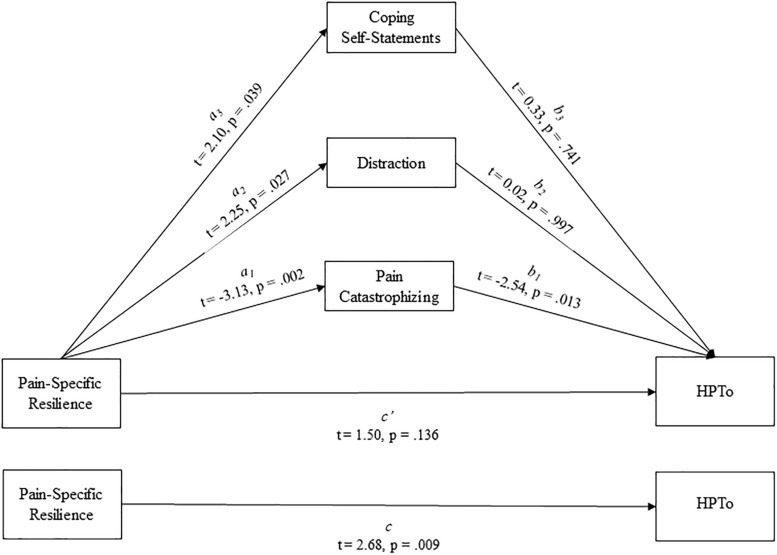
Parallel mediation model depicting the indirect effects of pain-specific resilience on heat pain tolerance (HPTo) through pain catastrophizing, distraction, and coping self-statements.